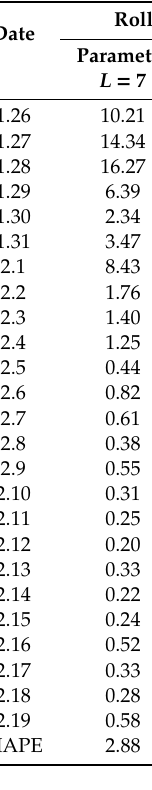
Table 3. APE values and MAPE values of the training